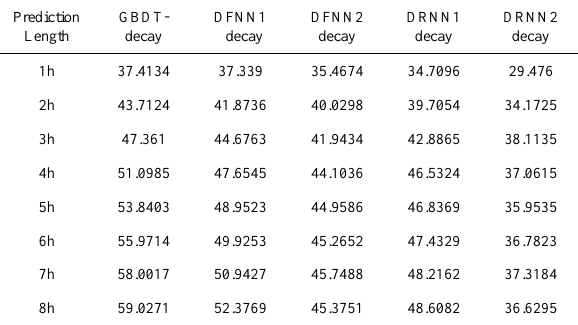
Table 8. Accuracy of models based on decay-fix Performances of models based on three fix methods are illustrated in figure 7~9 below.